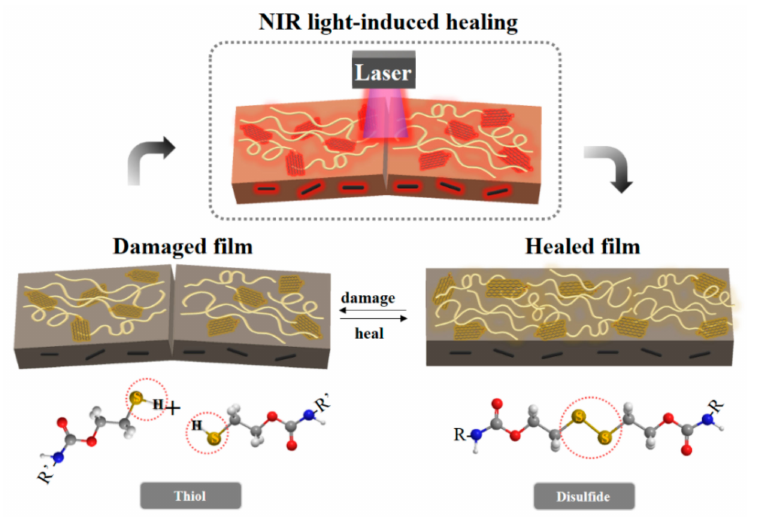
Figure 1. Schematic illustration of self-healing system using photothermal polydopamine-coated graphene oxide (PDA–rGO) triggered by near-infrared (NIR)